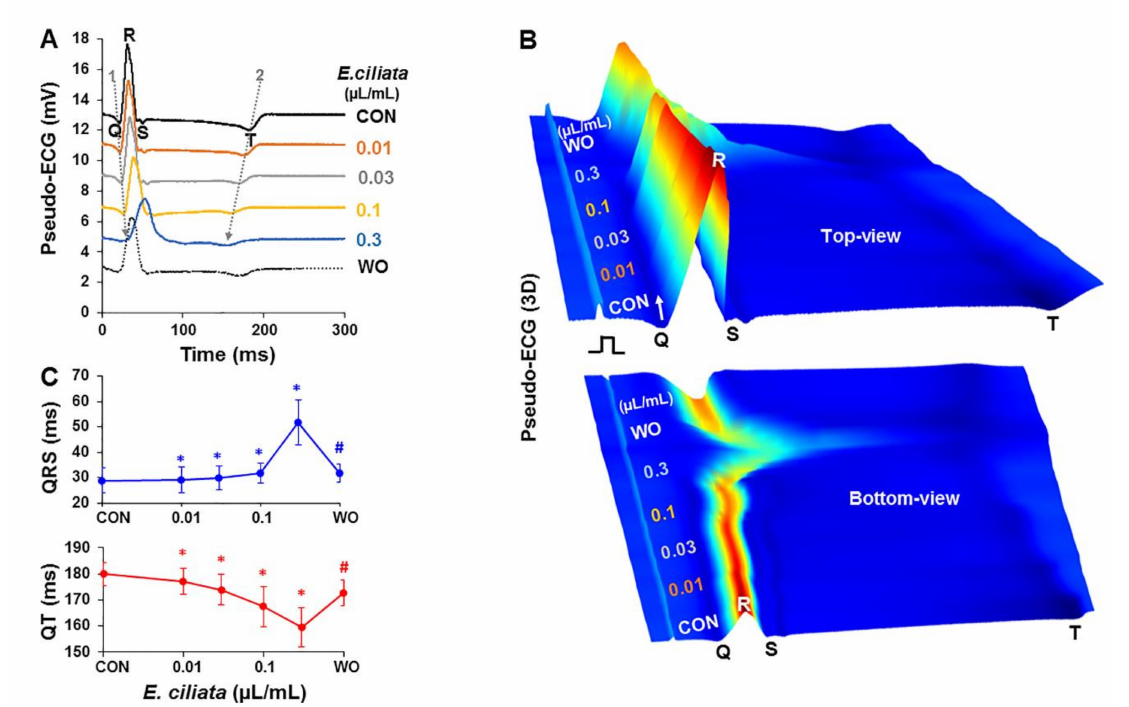
Figure 1. E. ciliata e ff ects on the pseudo ECGs of Langendor ff -perfused rabbit hearts. Epicardial pacing with a 300 ms period was applied. ( A ) Superimposition of steady-state pseudo ECG traces under control conditions (CON; black) and after application of 0.01, 0.03, 0.1 and 0.3 µ L / mL concentrations of E. ciliata (orange, grey, yellow and blue, respectively) for 10 min each, followed by perfusion without E. ciliata (WO; dotted). Q, R, S, and T waves indicated. Notice a lengthened time-to-R max and shortened QT interval as indicated by dotted arrows 1 and 2, respectively. ( B ) Three-dimensional (3D) view of pseudo ECGs, from front to back, showing time-dependent e ff ect of increasing concentrations of E. ciliata from the same data as in (A), constructed by LabChart8 Pro software ECG analysis plot function, in which the X, Y and Z axis represent location, time, and height of the detected peaks of the pseudo ECG, respectively. Wave amplitudes are indicated by colors from blue to red. ( C ) Mean data of QRS (upper) and QT (lower) interval change when applying di ff erent E. ciliata concentrations as indicated (* p < 0.05 for E. ciliata vs. control; # p < 0.05 for washout vs. E. ciliata of 0.3 µ L / mL concentration; n = 5 for each). Table 1. The e ffi cacy of E. ciliata essential oil action on pseudo ECG changes in the rabbit heart.